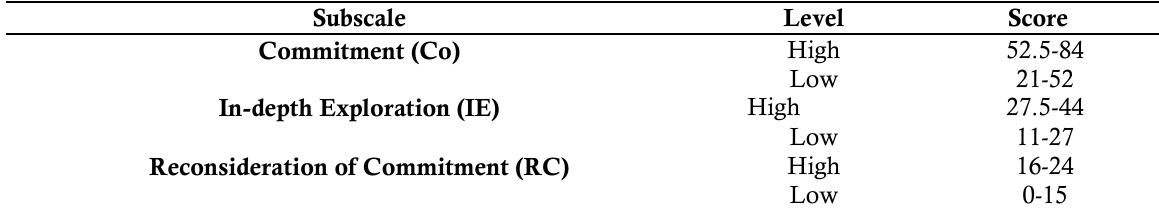
Table 1. Categorization of Participant‟s Scores